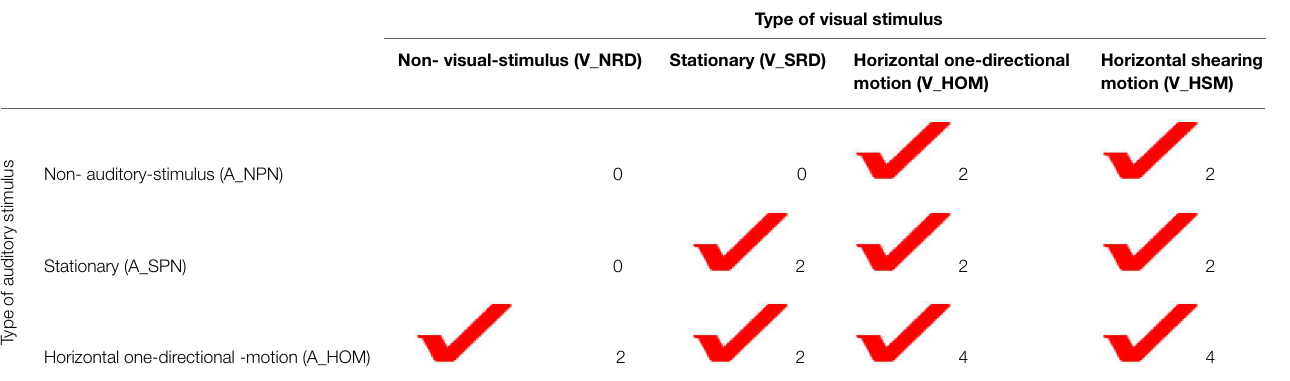
TABLE 1 | Detailed trial numbers in each experimental condition.